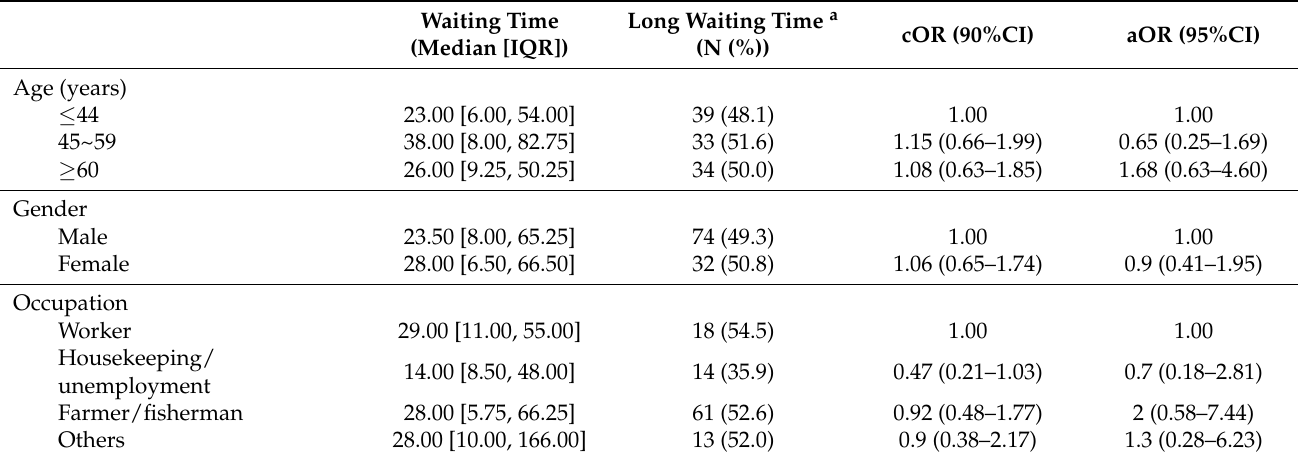
Table 2. Association of clinical and socio-demographic factors with waiting time for drug- susceptibility testing among MDR/RR-TB patients (N =